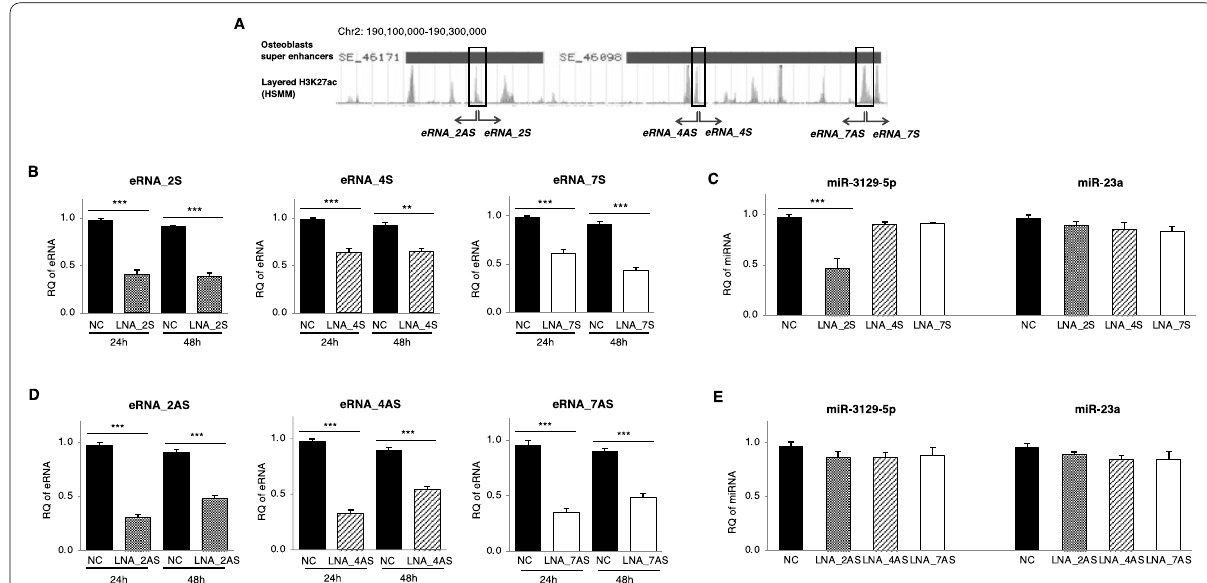
Fig. 3 Knockdown of eRNA_2S suppressed miR‑3129‑5p expression in hBMSCs. A Positions of the putative eRNA_2, eRNA_4, and eRNA_7 transcripts during MSC differentiation into osteoblasts. B , D Each sense ( B ) and antisense ( D ) eRNA was examined in MSCs transfected with antisense LNA GapmeR. C , E miR‑3129‑5p expression was examined in MSCs transfected with sense ( C ) and antisense ( E ) LNA GapmeRs for 24h. The expression of miR‑23a was examined as a control. The levels of eRNA and miRNA expression were quantified by qPCR. The amounts of eRNA and miRNA transcripts were expressed relative to the amounts of GAPDH and U6sn transcripts, respectively. Data are expressed as mean SD from ± three independent experiments (each n 3 in B , C , D , and E ). ** p 0.001, *** p < 0.001 vs. NC by Student’s t ‑test and one‑way ANOVA. LNA, locked = = nucleic acid; NC, LNA GapmeR‑negative control; S, sense; AS, antisense; RQ, relative